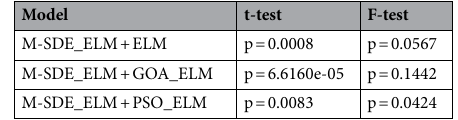
Table 5. Hypothesis tests of single